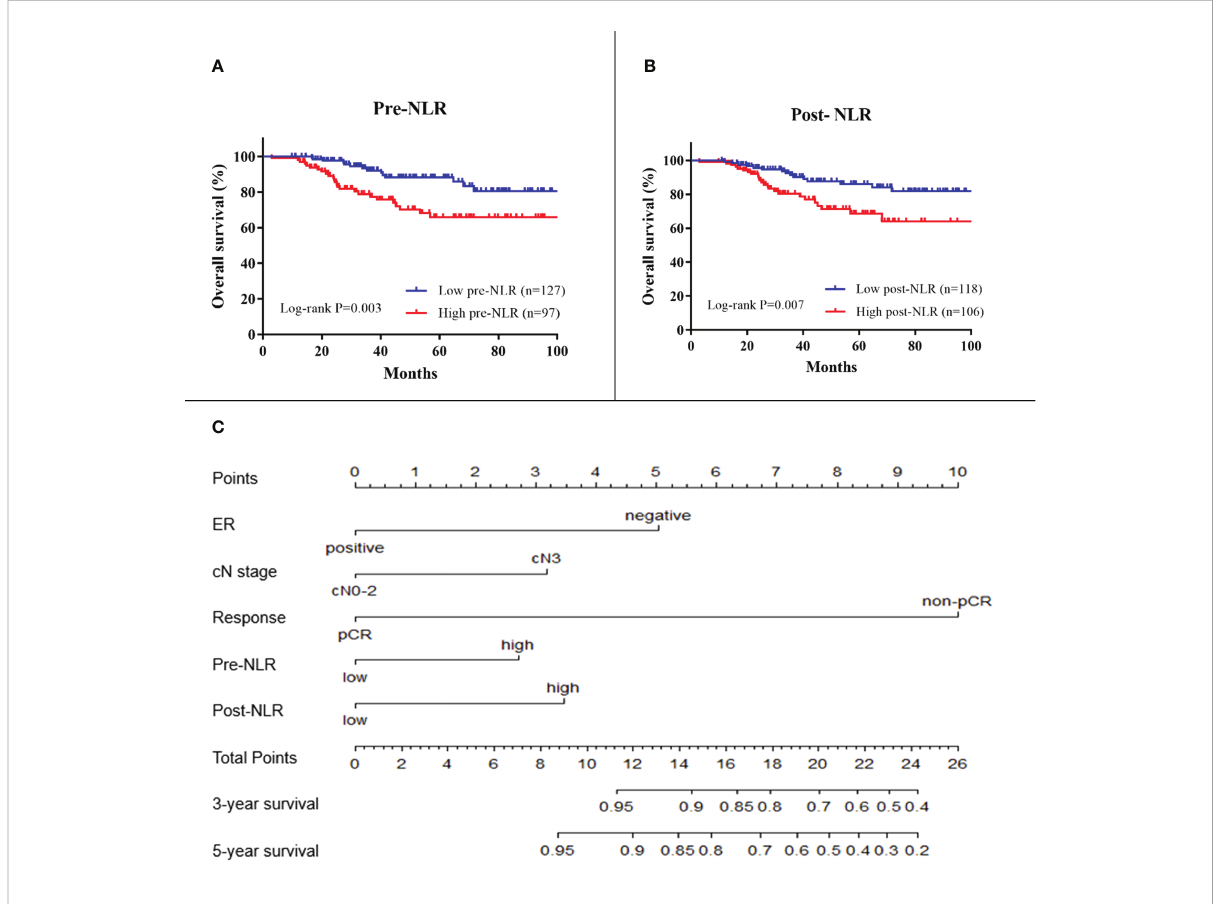
FIGURE 2 Kaplan – Meier survival plots of pre-NLR (A) and post-NLR (B) for overall survival. A nomogram (C) for predicting survival in breast cancer patients receiving NAC. ER, estrogen receptor; cN, clinical lymph node; NLR, neutrophil-to-lymphocyte ratio. Response is the response to neoadjuvant